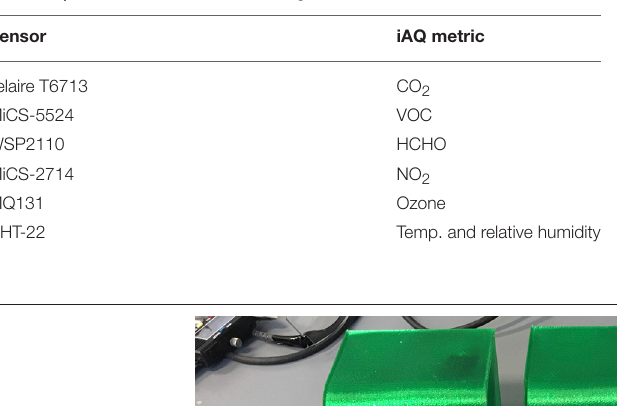
TABLE 1 | All sensors used in node configurations.